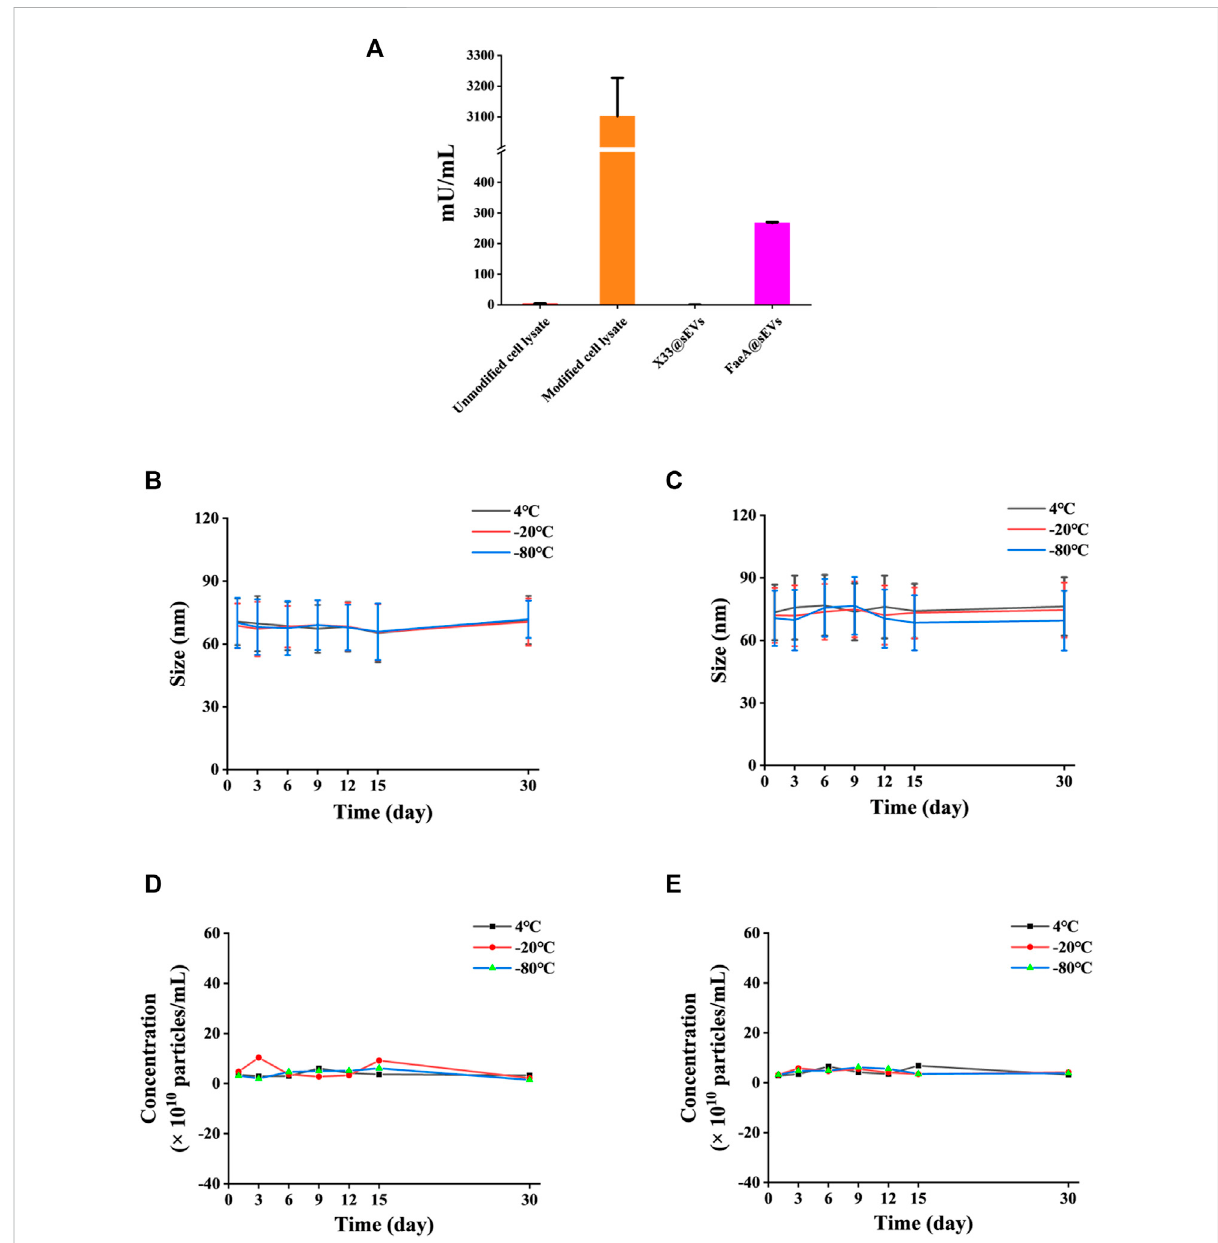
FIGURE 4 EsterasehydrolysisandstoragestabilityofFaeA@sEVs. (A) EnzymaticactivityofintracellularproteinsandFaeA@sEVs. (B) Changesintheparticle size distribution of X33@sEVs stored at 4, − 20 and − 80 ° C within 30 d. (C) Changes in the particle size distribution of FaeA@sEVs stored at 4, − 20 and − 80 ° C within 30 days (D) Changes in the particle concentration of X33@sEVs stored at 4, − 20 and − 80 ° C within 30 d. (E) Changes in